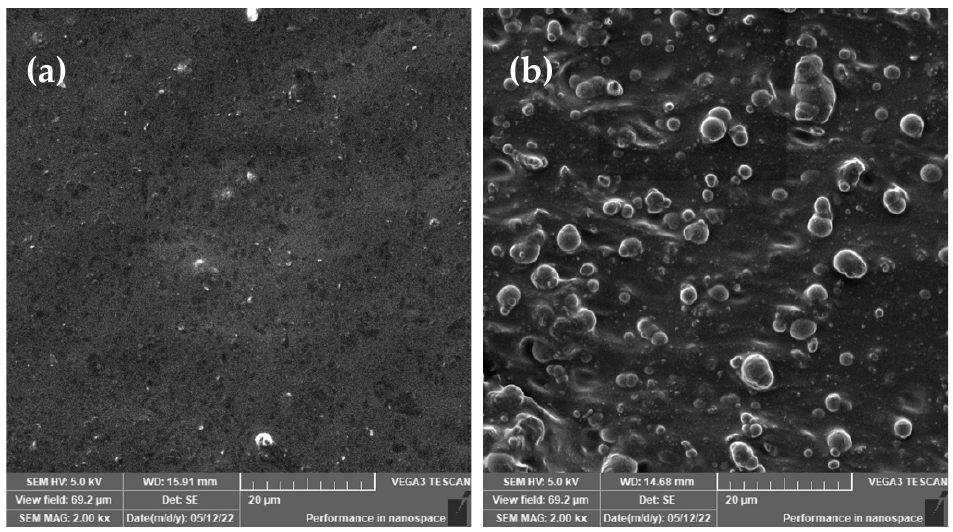
Figure 1. SEM micrographs of ( a ) MRE sample surface morphology, and ( b ) MRE sample cross-section.